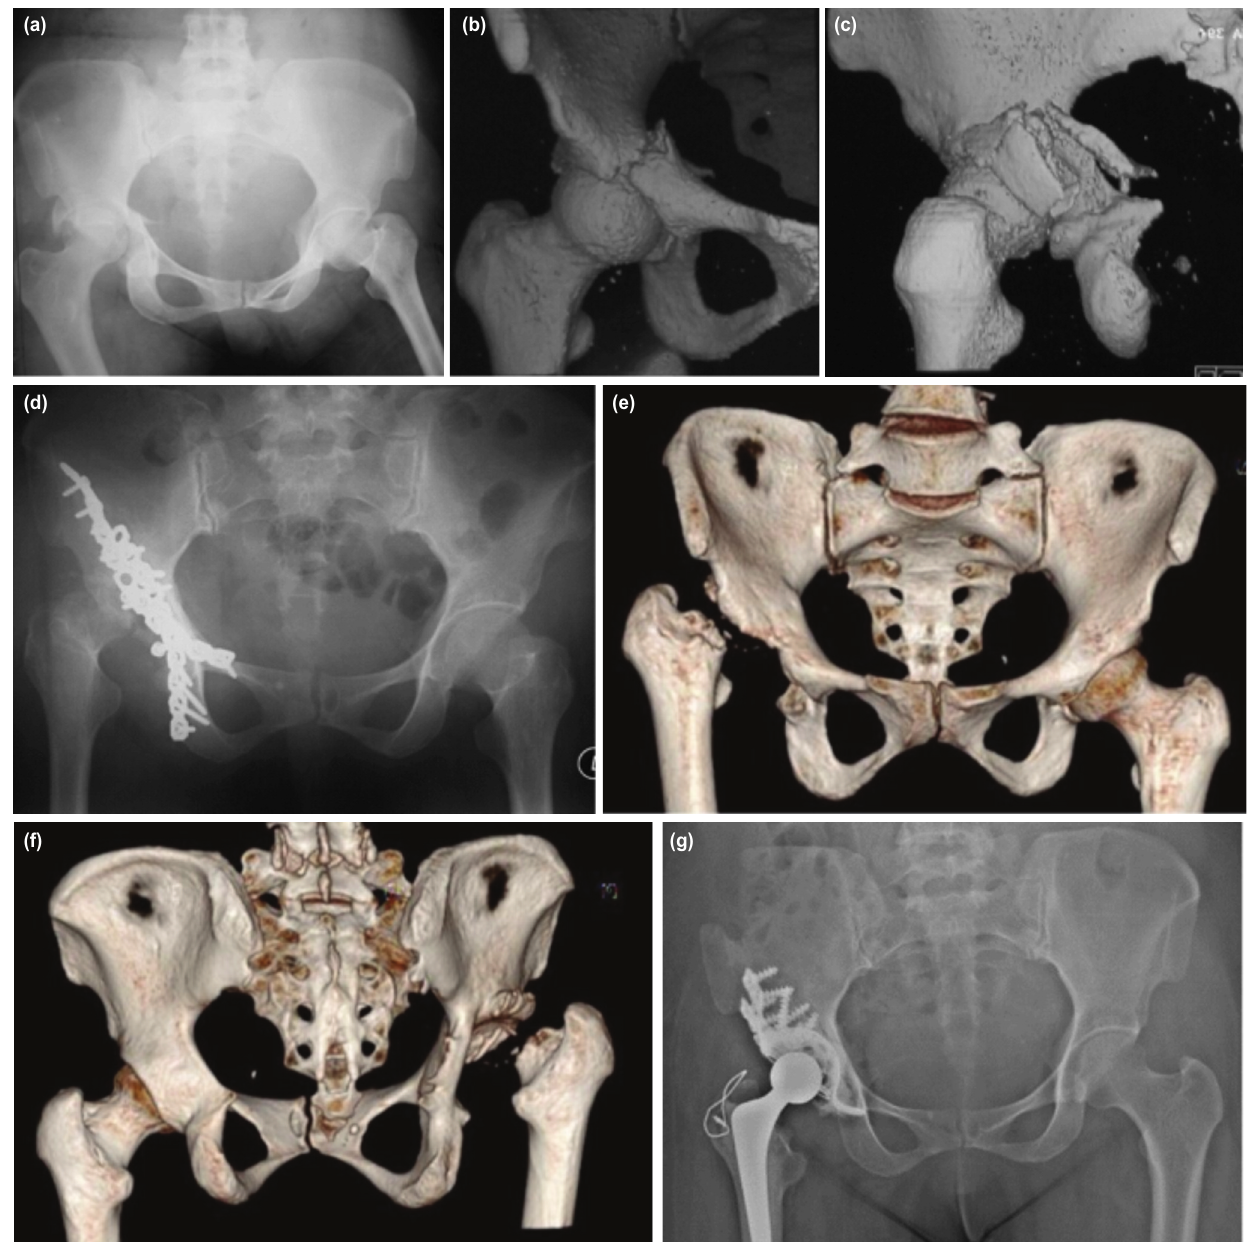
Transverse bicolumnar fracture with posterior column injury in 54-year-old lady was stabilised with double approach. It was Fig. 1: complicated with infection requiring removal of all implants and prolonged antibiotic treatment. (a) Anteroposterior view radiograph shows a displaced transverse bicolumnar fracture with posterior column injury. (b) Closed up anteroposterior CT scan image of the fracture. The fracture line extends from the anterior column, traversing to the posterior. (c) Closed up posterior view of CT image shows comminuted medial and posterior wall. (d) Anteroposterior pelvic radiograph of bicolumnar plating of the acetabulum. This patient succumbed to implant related infection which lead to septic arthritis and AVN with femoral head lysis. (e) Anteroposterior view of CT image of right hip after removal of implant and remaining collapsed femoral head. Note part of anterior wall has undergone lysis too. (f) CT image posterior view of right hip shows the absent posterior wall of acetabulum. (g) There was no femoral head to build up the posterior wall, the illiac crest was used to build up posterior wall with impacted graft and cage cemented